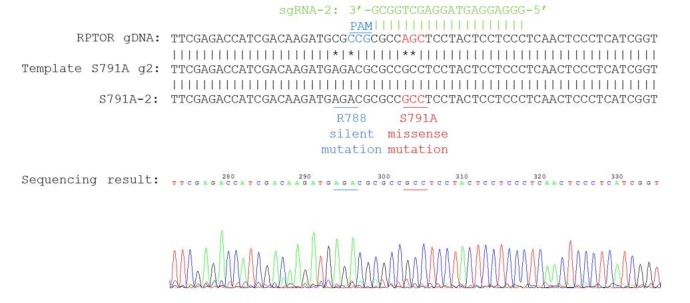
Sequencing chromatogram for knock-in clone S791A-2.